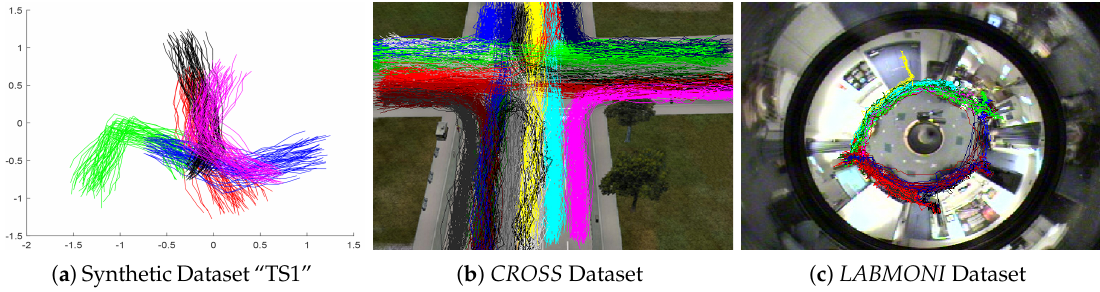
Figure 3. Plots of trajectory datasets used for the evaluation of distance measures. Trajectories in the same cluster have the same